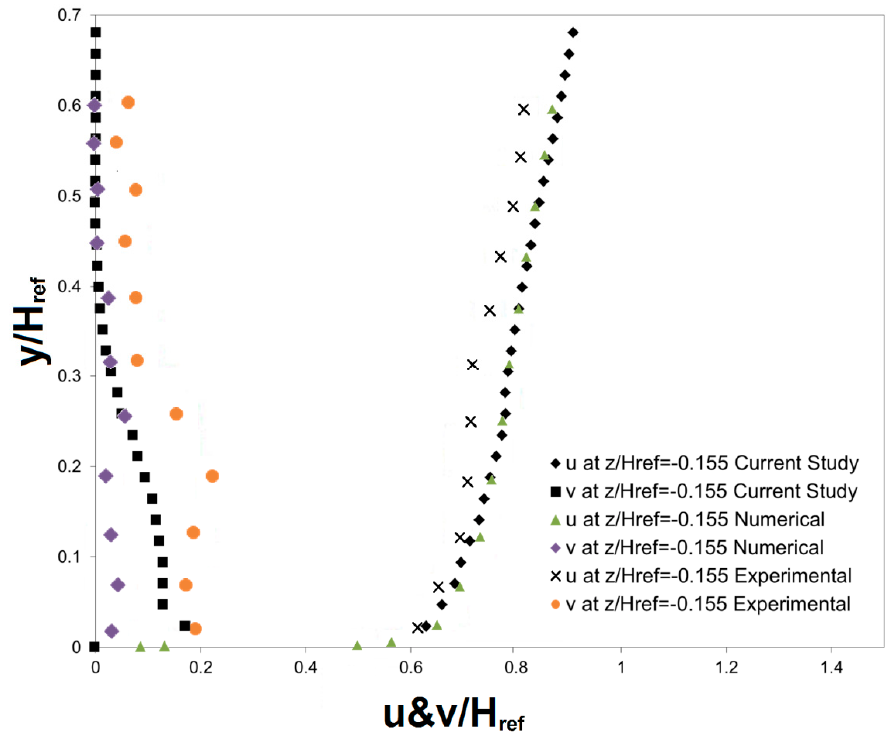
Figure 8. Comparison between numerical predictions and numerical/experimental data [37] for streamwise and cross-stream velocity results at z / H ref = − 0.155.